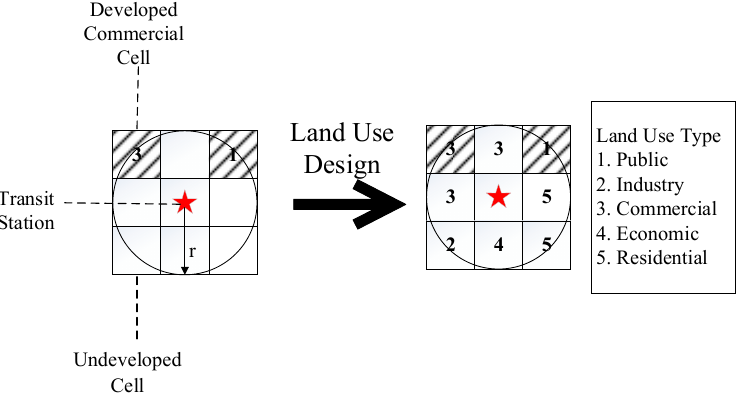
Figure 1. Description of the land use design problem.